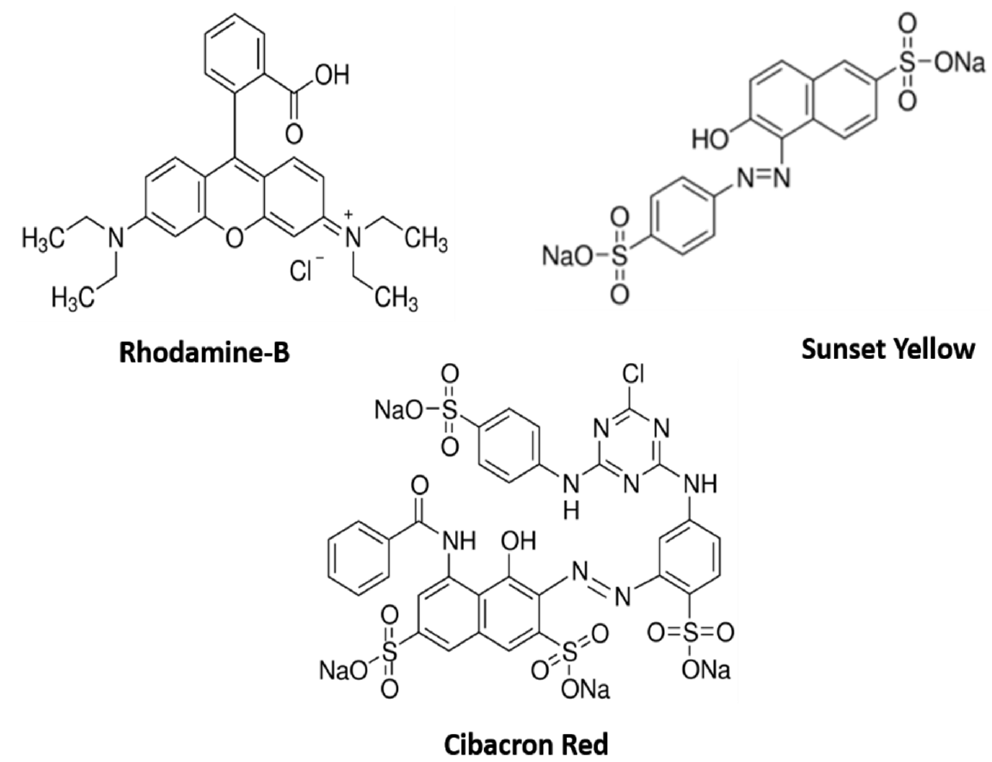
Figure 1. Chemical structure of three different dyes.